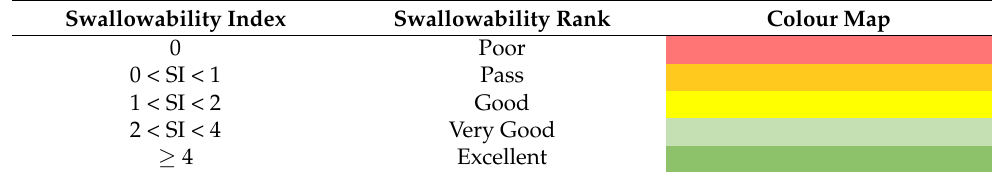
Table 5. Colour-coded matrix to rank the in-vitro swallowability of film coated tablets using the swallowability index derived from the triangulation of critical physical factors governing the swallowing